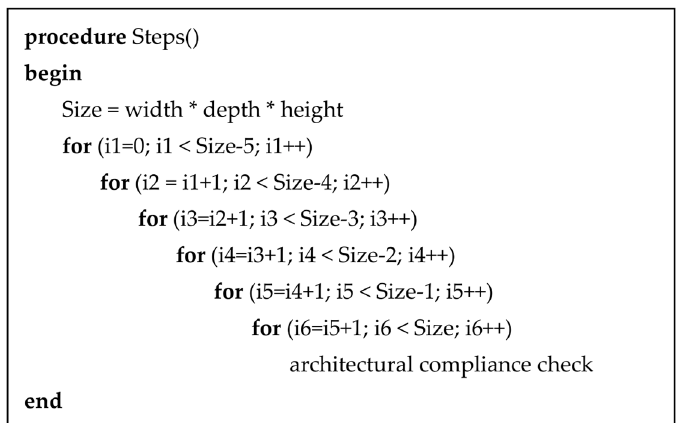
Figure 4. Generation procedure of the 6 blocks.